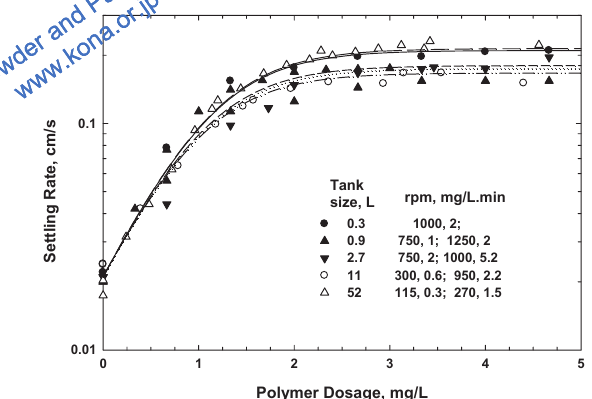
Fig. 9 Scale-up conditions for limiting floc size. Floc development at a fixed agitator tip speed of 270 cm/s and constant rate of polymer addition for different tank sizes. Data of Maffei 34)